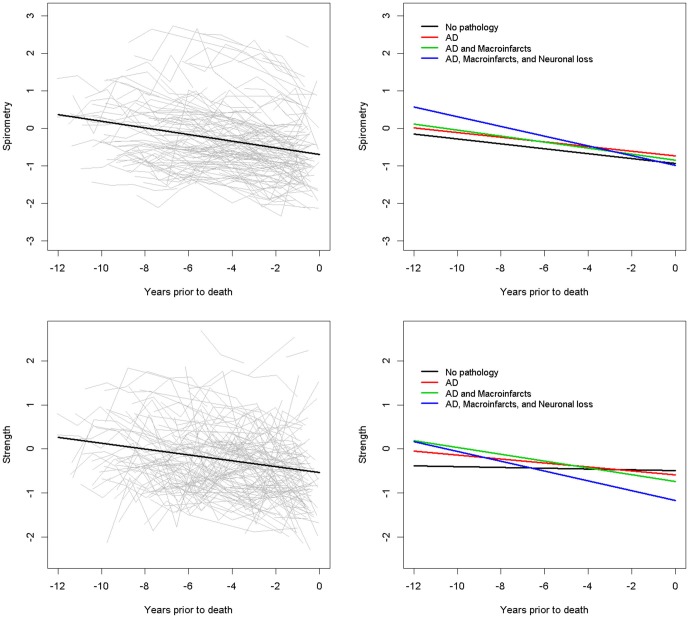
Change in spirometry (SPI) and respiratory muscle strength (RMS) and the effect of more brain pathology on their rates of change. The left panels show change in SPI (top) and RMS (bottom) during the study. Crude paths of change (gray lines) and mean paths of change predicted by the model (black lines) in SPI (top) and RMS (bottom). To facilitate visualization data from a 25% random sample of decedents is illustrated in the left panels. To display the association of brain pathology on the rate of change in respiration, four hypothetical average participants with their estimated rate of declining respiration based on the model which included all the cases analyzed in this study are illustrated. The right panels show the model derived predicted paths of SPI (top) and RMS (bottom) for four participants with increasing burden of brain pathology: (1) Black line, the predicted path for a participant with No pathology; (2) Red line, the predicted path for a participant with Alzheimer’s disease (AD) pathology; (3) Green line, the predicted path for a participant with AD pathology and macroinfarcts; (4) Blue line, the predicted path for a participant with AD pathology, macroinfarcts and severe nigral neuronal loss.